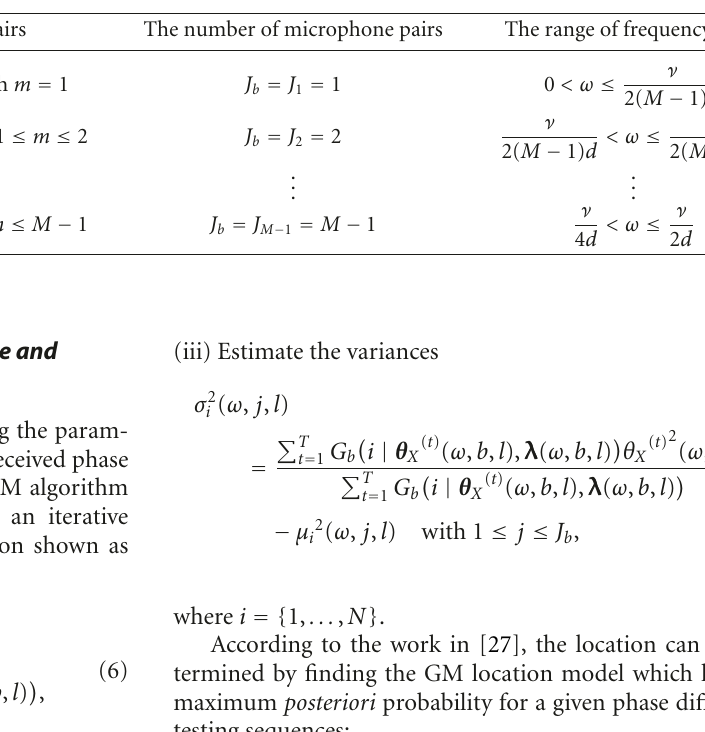
Table 1: Relationship of frequency bands to the microphone